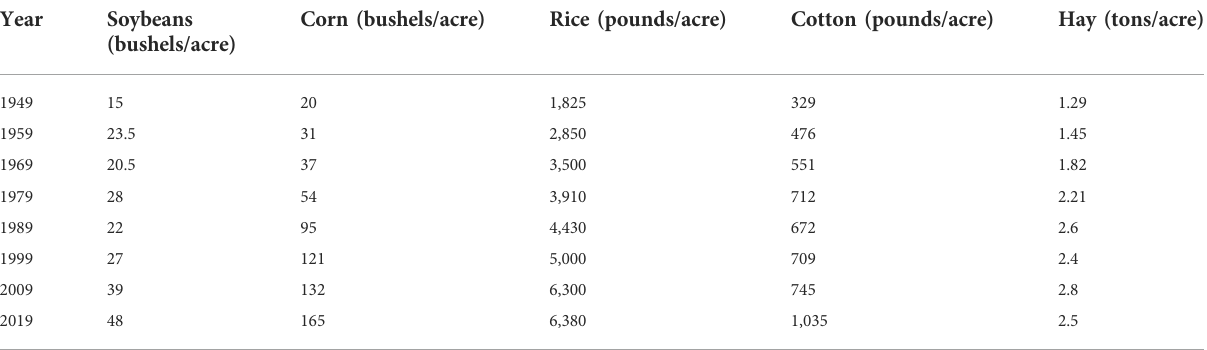
TABLE 2 Yields of the top fi ve Louisiana crops by value (source: USDA NASS 2020).